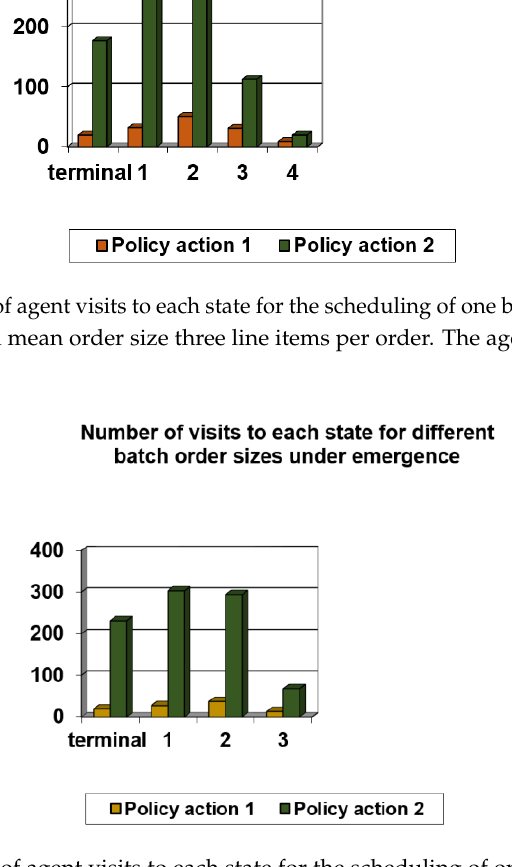
Figure 15. Top page of the implemented CTPN model for the scheduling of five batches of 28 orders each with order size of two line items per order. The color tokens show the order sequencing from top to bottom, with the list of tote pick locations and compartment pick locations, as well as the cumulative workload schedule.